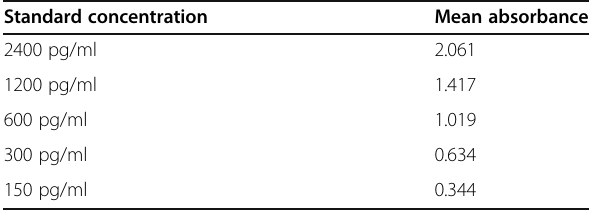
Table 1 Absorbance values (OD) against the standard